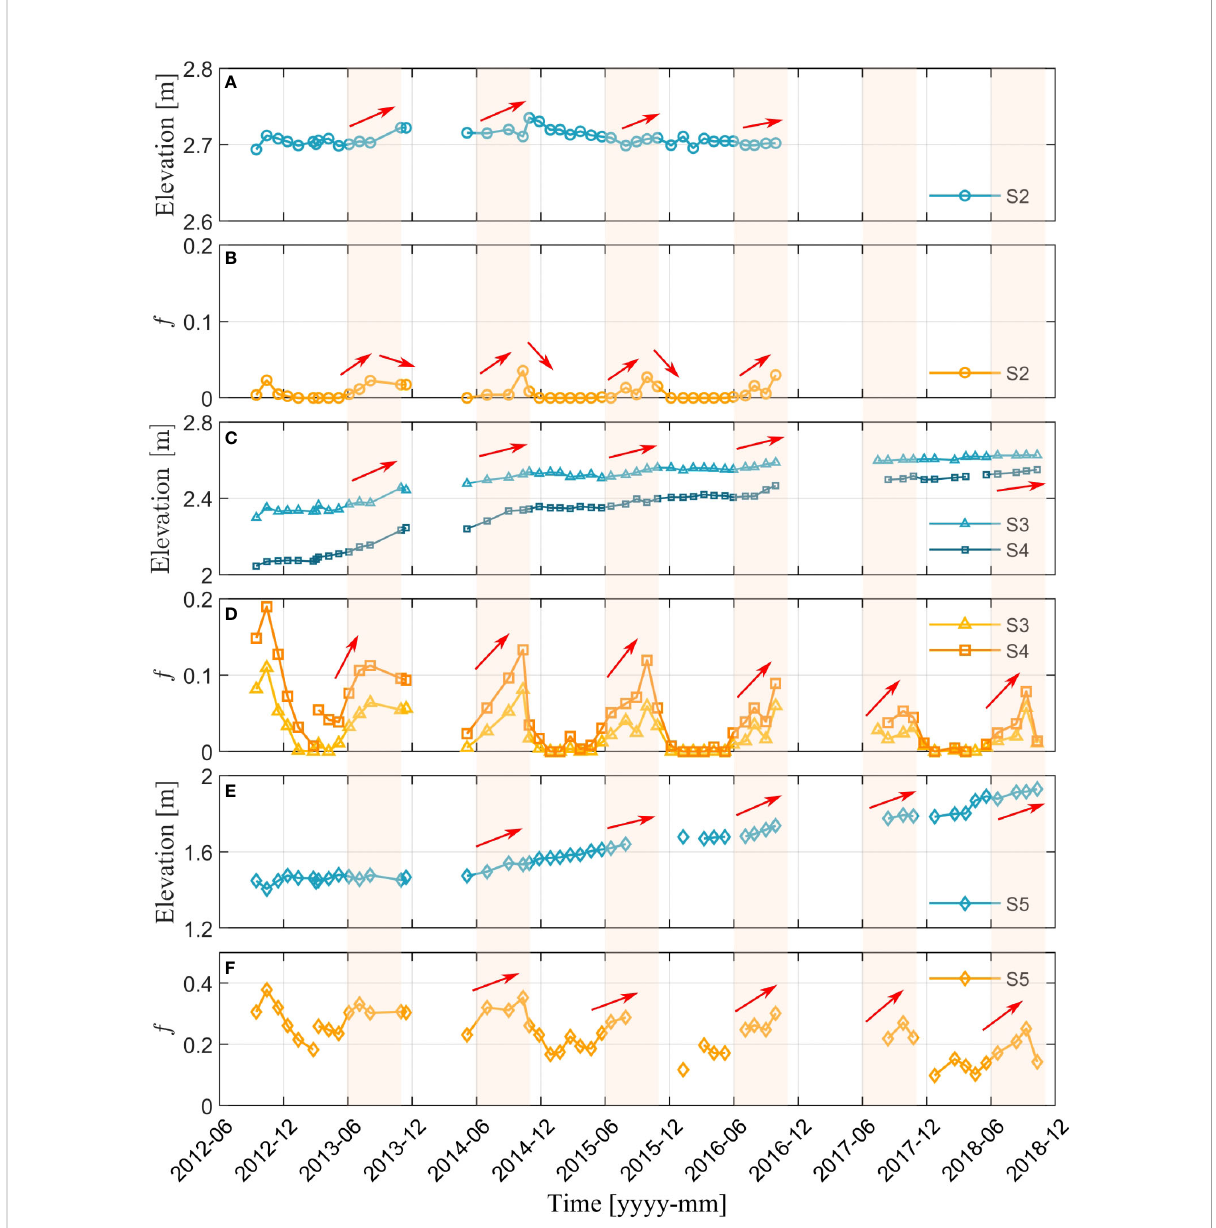
FIGURE 3 Variation of the soil surface elevation at sites (A) S2, (C) S3 and S4, (E) S5, and (B, D, F) their corresponding inundation frequency. Light yellow shades highlight the months June to November with the increase in the inundation frequency. Red arrows highlight the increasing trend of the soil surface elevation and inundation